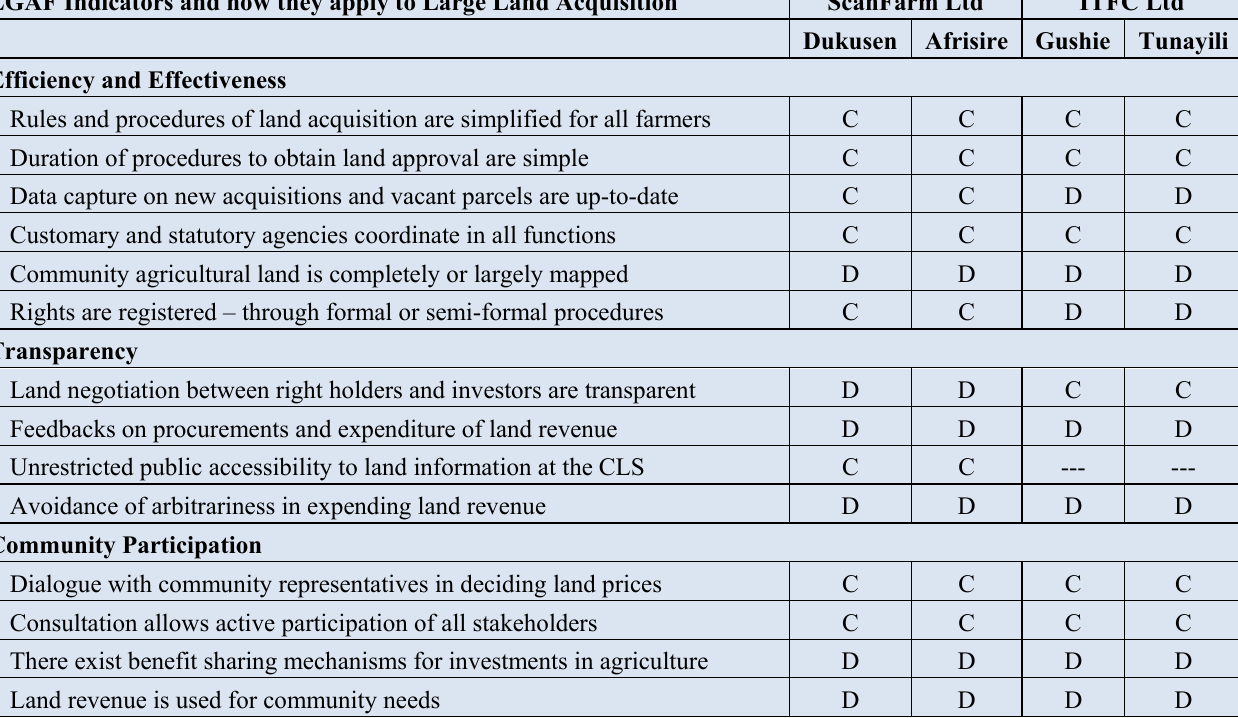
Table 4. LGAF Indicators and how they apply to Large Land Acquisition. Source: Field Data